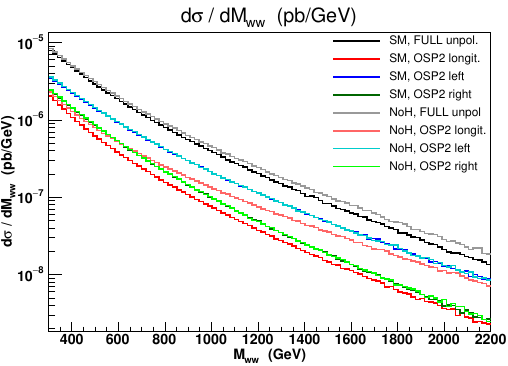
Figure 8. M WW distribution in the Higgsless model compared with the SM results. p e j (cid:17) e j < 2 :